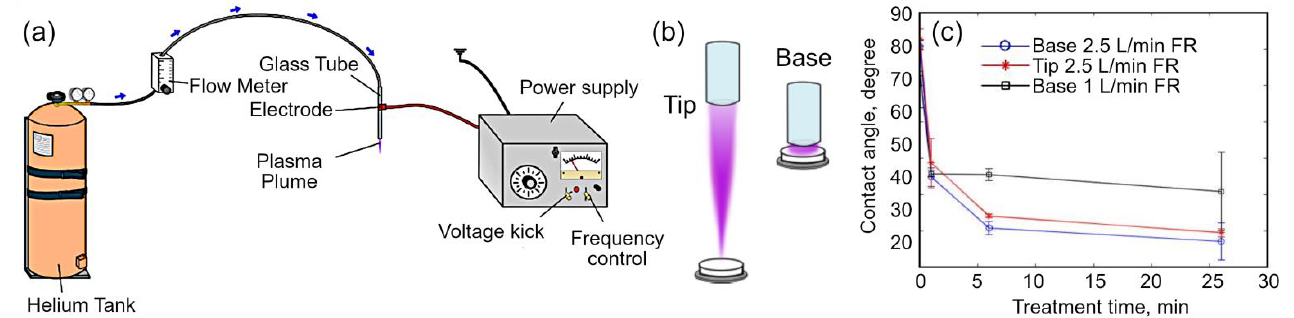
Figure 3. ( a ) Schematic of cold atmospheric plasma (CAP) source used for the treatment of the ultra-high-molecular-weight polyethylene (UHMWPE) samples. ( b ) Tip and base treatment locations of the UHMWPE samples in the plasma plume. ( c ) Contact angle measurements as a function of the treatment time varied from 1 to 26 min. Reproduced from Turicek et al. (2021) [38] under conditions of the CC BY license.